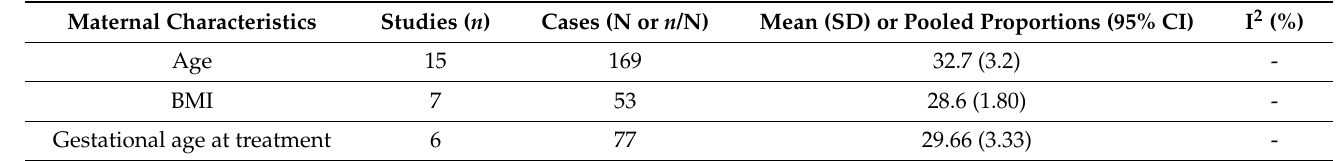
Table 3. Maternal characteristics expressed as mean ± standard deviation (SD) or in terms of pooled proportions with their 95% confidence intervals